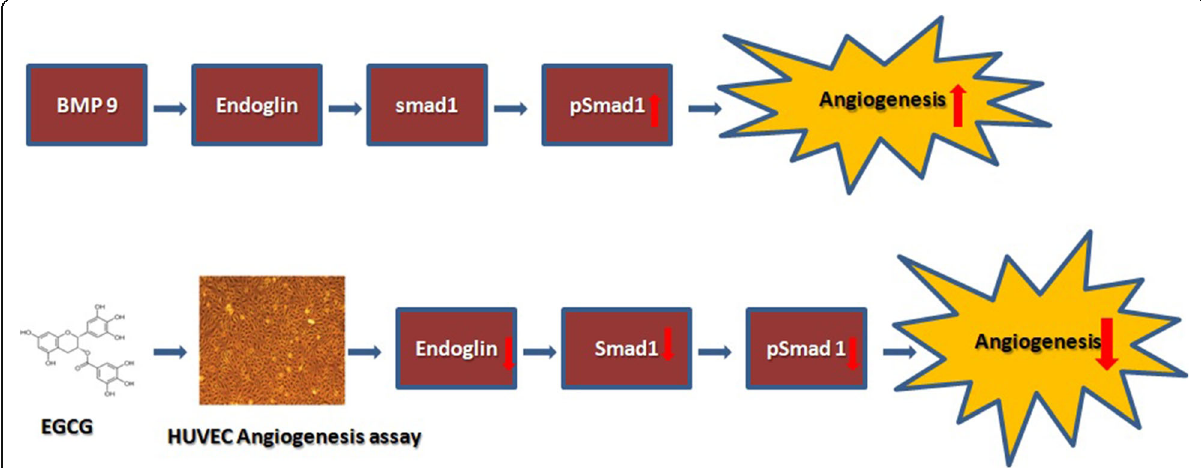
Fig. 3 A representation describing the molecular mechanism of EGCG on antiangiogenic activity in HUVEC